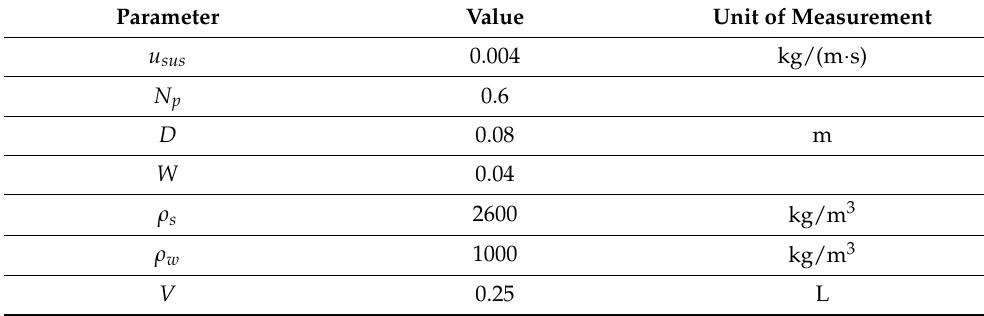
Table 2. Data to calculate the mean shear